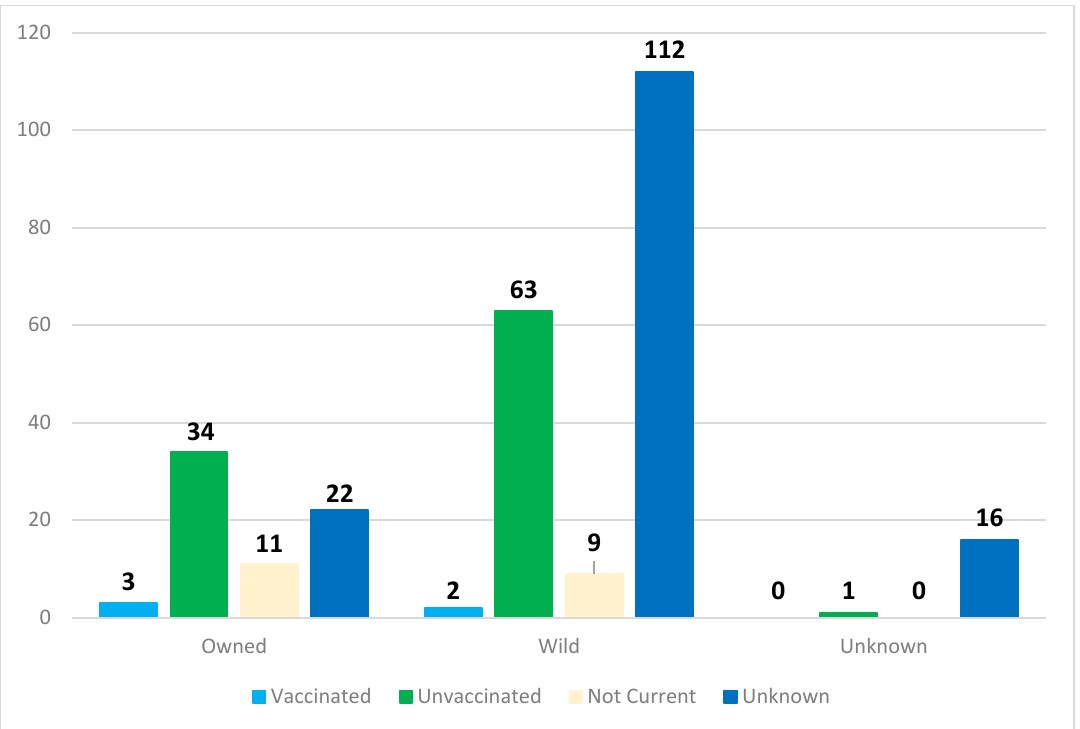
Figure 3. Ownership and vaccination status of rabies-positive cats submitted to the NYSDOH Rabies Laboratory that had either bitten or scratched a human.